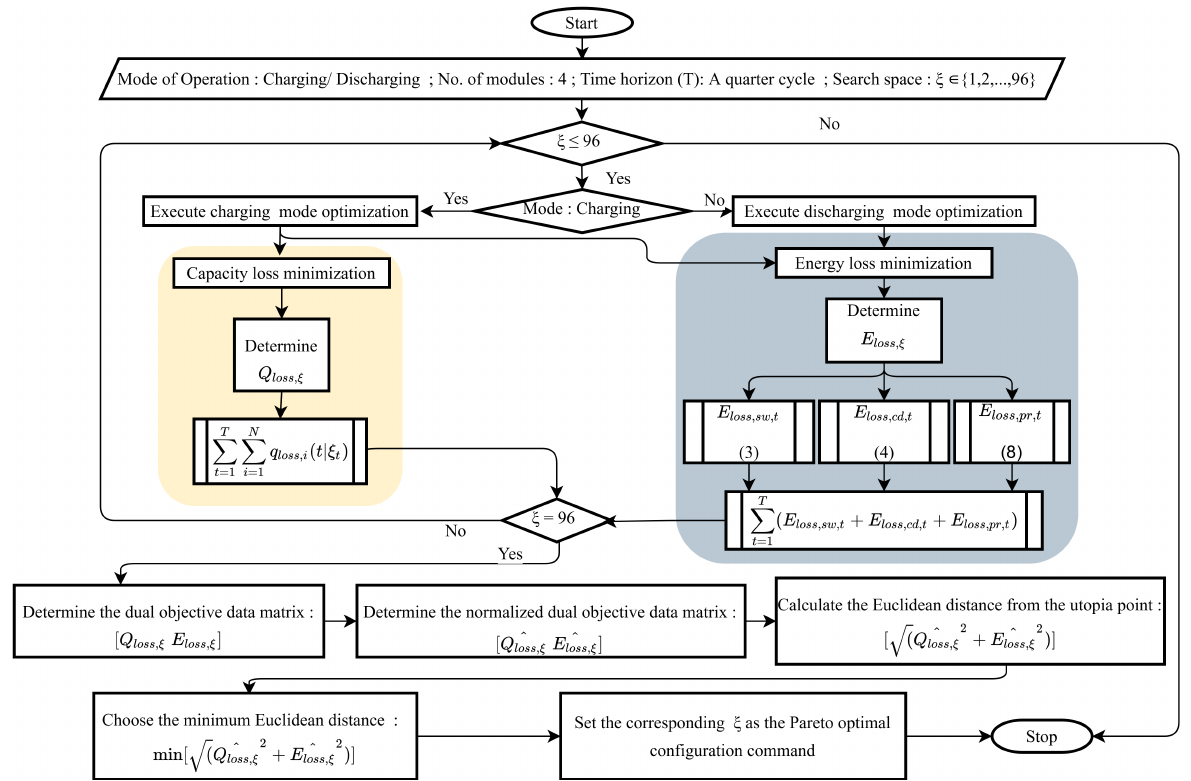
Figure 4. Flowchart for the proposed MOO-based scheduler for charging and